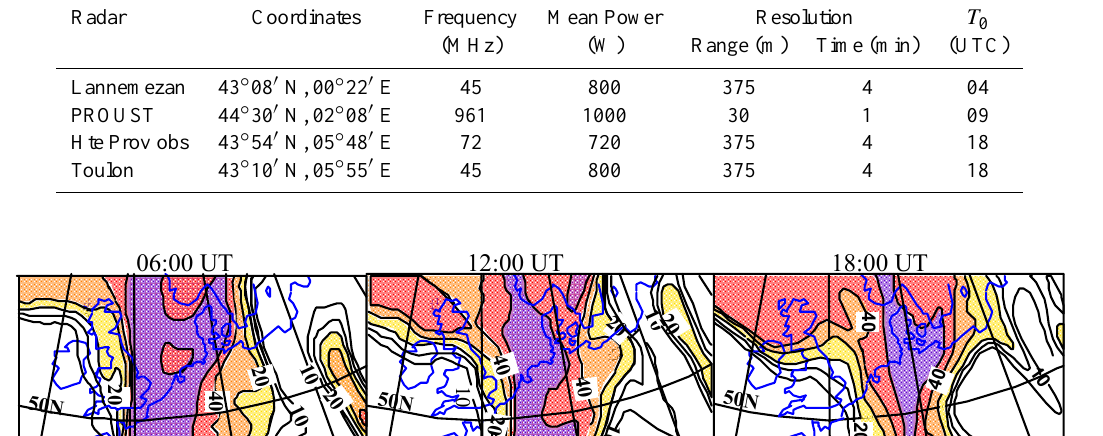
Table 1. Main characteristics of the network and advection time of the PV anomaly between the different sites Radar